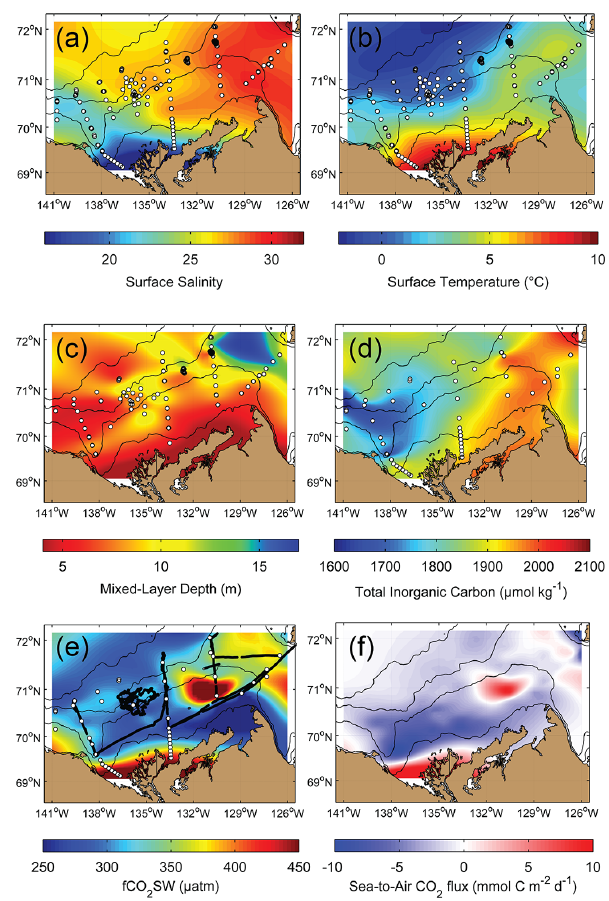
Figure 4. Gridded composites of in situ physico-chemical data ob- tained at the sampling stations (white dots) conducted in the Beau- fort Sea in mid-summer 2009 (Fig. 1): (a) surface salinity, (b) sur- face temperature, (c) depth of the mixed layer delimiting the surface and subsurface layers as used in this study, (d) concentration of dis- solved inorganic carbon, (e) sea surface CO 2 fugacity (combined data set from the underway system and bottle data), and (f) the sea- to-air CO 2 fluxes (blue: flux to the ocean; red: to the atmosphere) as computed following the methodology described in Sect. 2.3. Bathy- metric contours are 20, 100, 1000, and 2000m. The region close to Cape Bathurst on the eastern shelf is known to be a region where wind-driven upwelling is enhanced by the steep topography (see Williams and Carmack,